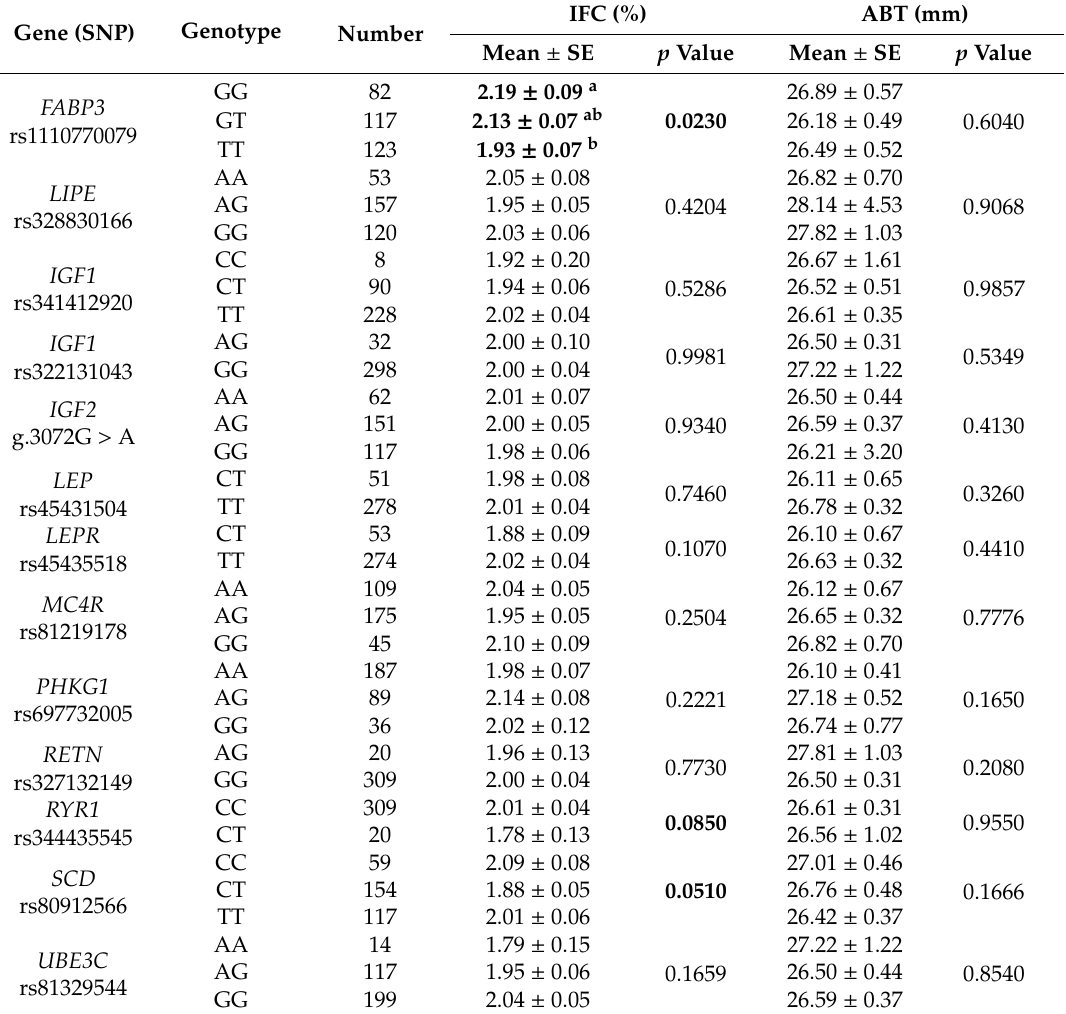
Table 3. Association analysis of 13 SNPs in 12 previously reported candidate genes with the intramuscular fat content (IFC) and average backfat thickness (ABT) of Suhuai